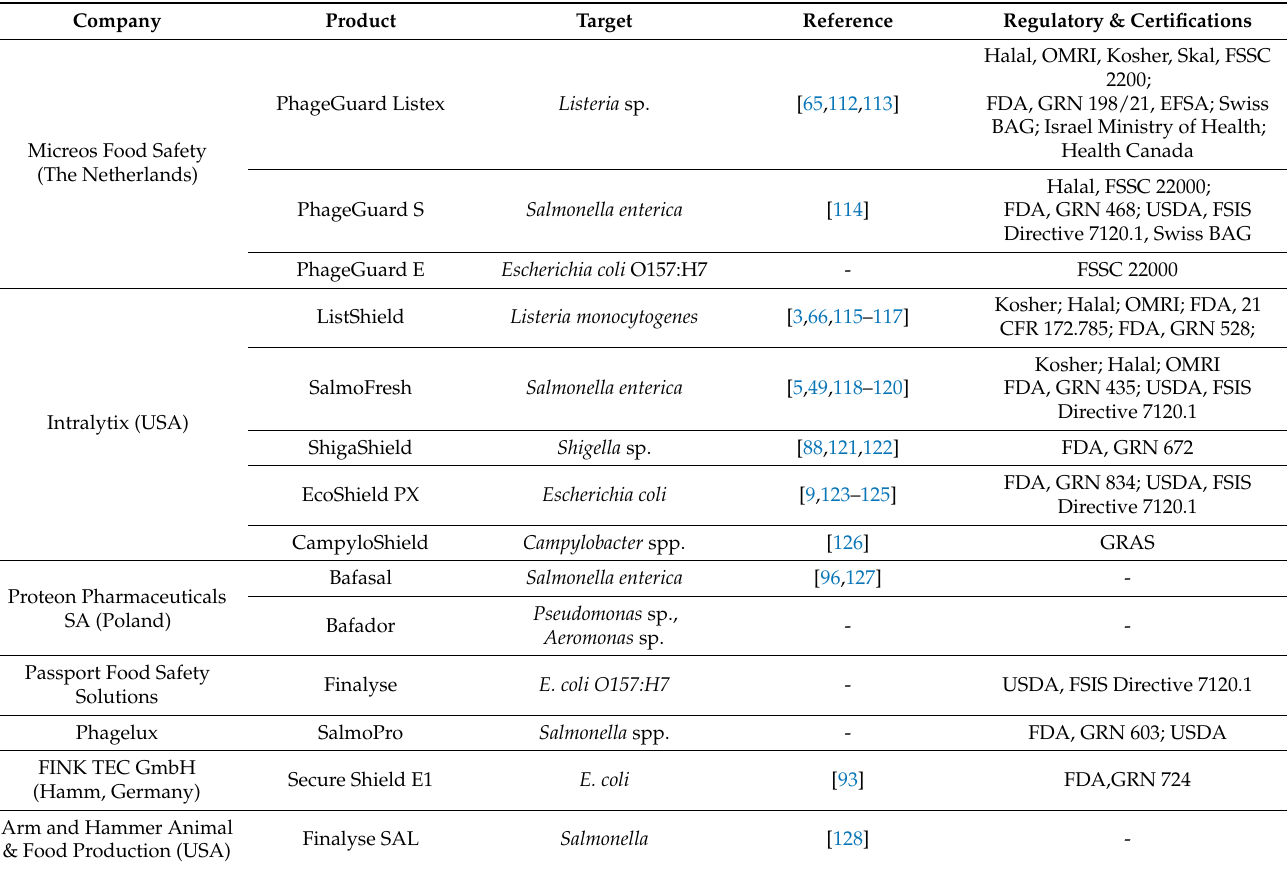
Table 2. Selected commercial bacteriophage